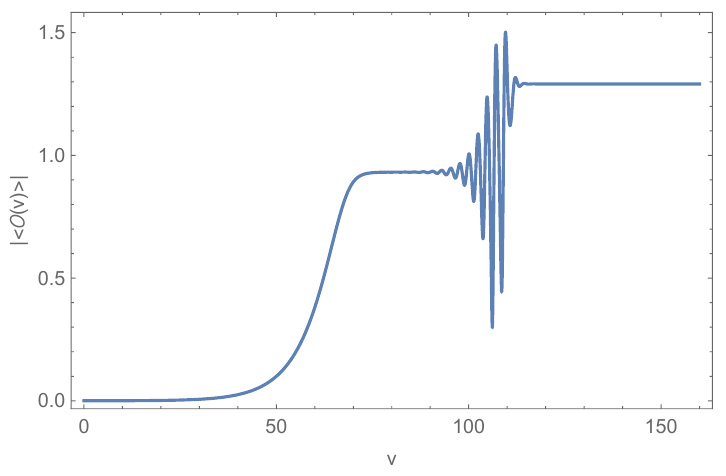
Figure 3 . The time evolution of superconducting order parameter hOi for Q = 2 and q = 6 . 5 . between the n = 0 and n = 1 modes,